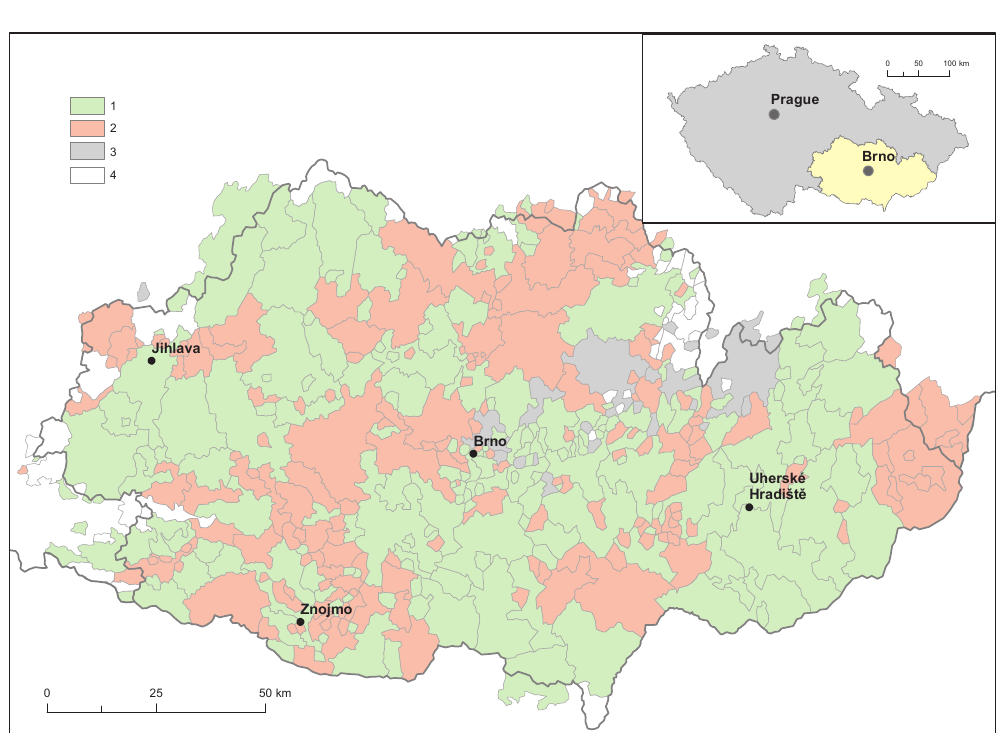
Figure 3. Spatial coverage of estates of South Moravia in 1848 with reference to hydrometeorological extremes (HMEs): (1) with HME records, (2) without HME records, (3) not accessible for research, (4) with administrative centre beyond South